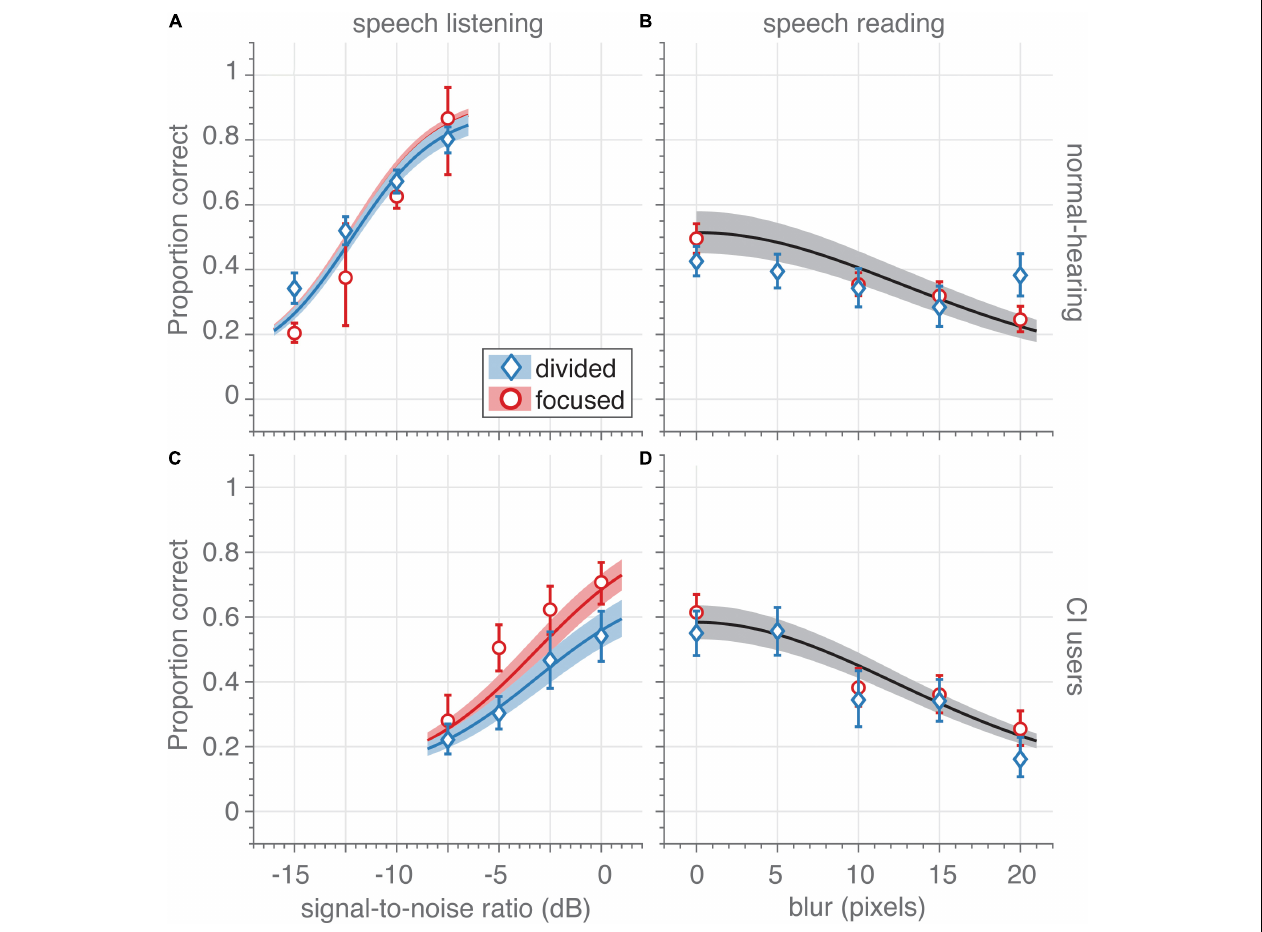
FIGURE 2 | Unisensory speech recognition. (A,C) Auditory-only speech recognition (proportion correct) as a function of signal-to-noise ratio (dB) for (A) normal-hearing participants ( n = 14) and (C) CI users ( n = 7) in the focused- (red circles) and divided-attention (blue diamonds) tasks for auditory-only trials (visual blur is 70 pixels). The trials in the focused-attention sessions contained informative stimuli of a single modality, while in the divided-attention task, trials with auditory, visual and audiovisual informative stimuli were randomly interleaved. Only data from unisensory auditory and visual trials are shown in these figures. Note that although the unisensory stimuli were the same for both tasks, CI users recognized more auditory words correctly in the focused-attention task (red) than in the divided-attention task (blue). This effect was absent for the normal-hearing participants. (B,D) Visual-only speech recognition as a function of spatial blur (in units of pixel standard deviations) for (B) normal-hearing participants and (D) CI users in the focused- (red circles) and divided-attention (blue diamonds) tasks for visual-only trials (no auditory signal is presented). Note that due to the large similarity in visual recognition scores for both tasks, a single psychometric curve was fitted through the combined data (black curve and patch). Symbols and bars indicate mean and 95%-confidence intervals, respectively, of the raw data (proportion correct) pooled across participants. The data were binned to four signal-to-noise ratios and five blurs (as indicated by the abscissa value) for graphical purposes. Curves and patches indicate means and 95%-HDI, respectively, of the psychophysical-function group-level